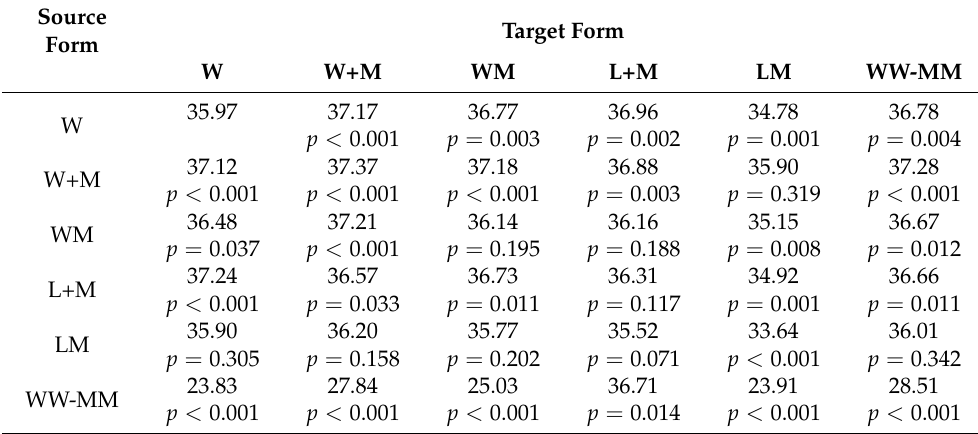
Table 8. BLEU scores and p -values for the translations from English to Slovene for different systems on the Europarl corpus.